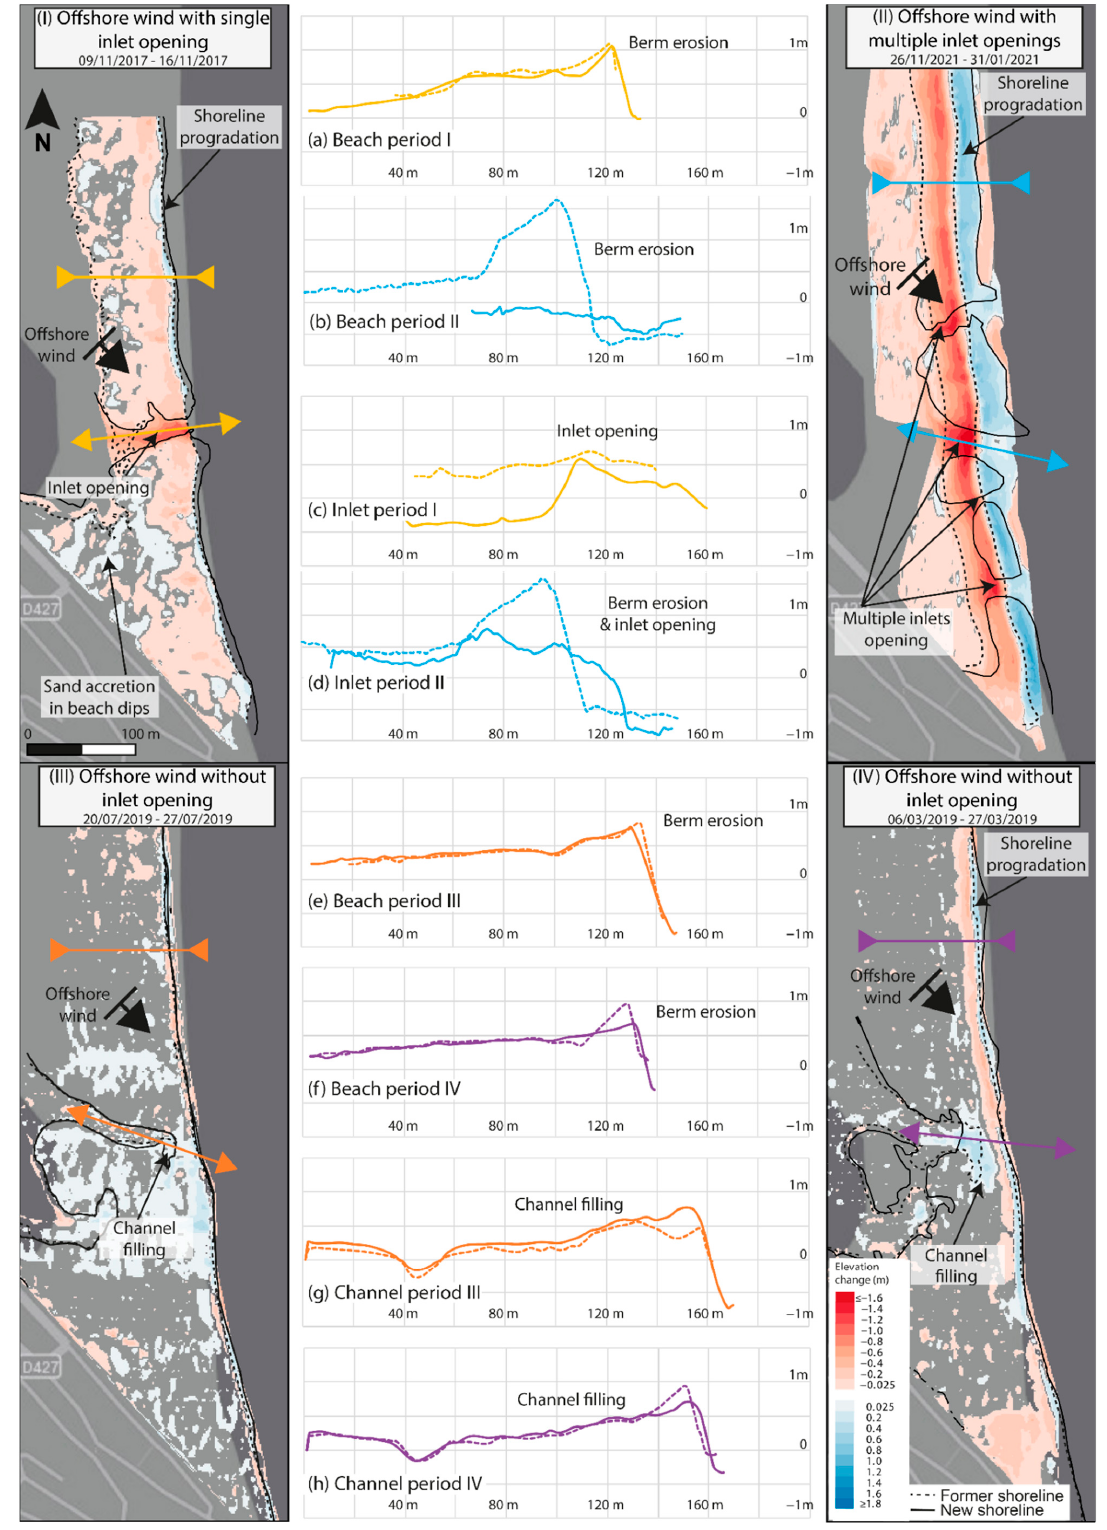
Figure 6. Morphological evolution of La Franqui beach, during periods of offshore wind with single ( I , a , c ) or multiple ( III , e , g ) inlet openings and during periods of offshore wind without inlet open- ing ( II , b , d & IV , f , h ). Dotted profiles correspond to the initial profile and solid profiles to the final